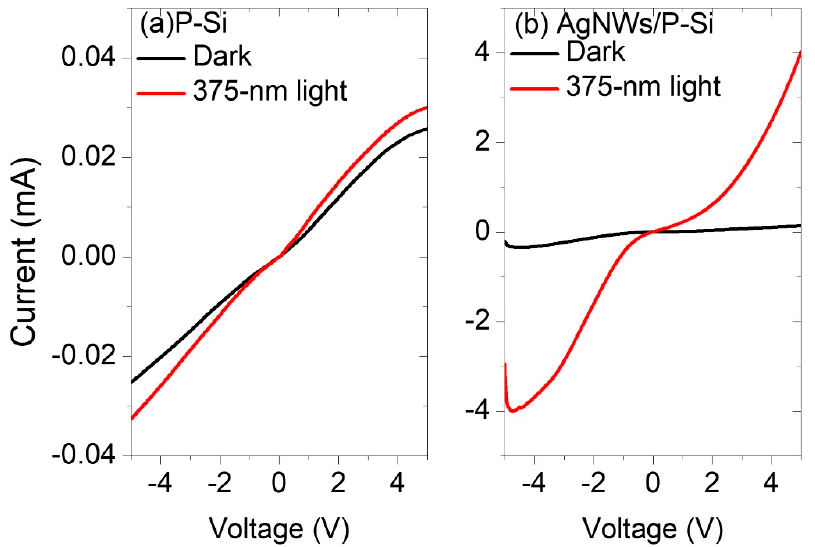
Figure 12. Current-voltage curves of the ( a ) P-Si and ( b ) AgNWs/P-Si photodetector under dark and 375 nm light.